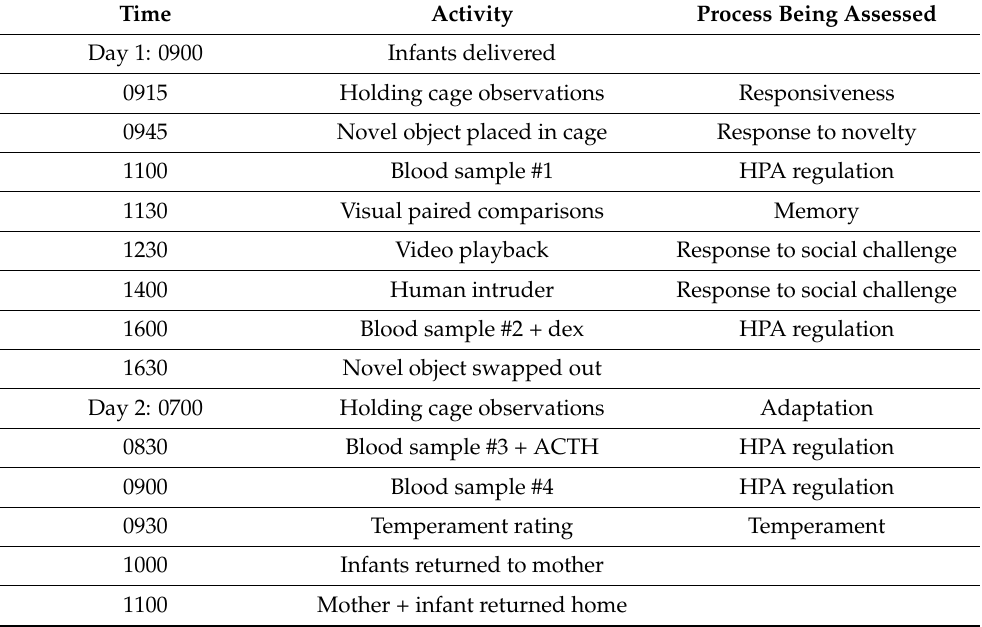
Table 1. Timeline for BBA Program